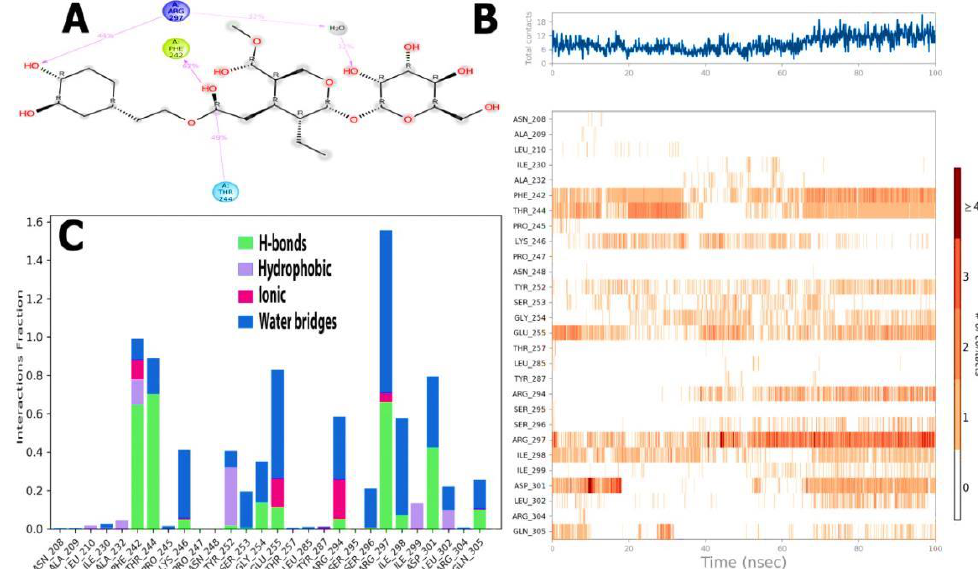
Figure 13. ( A ) Backbone RMSD values of the Cα atoms of the protein, ( B ) RMSF of the backbone atoms, ( C ) snapshots of the docking pose of oleuropein and the total H-bond intensity at various time intervals in the 20 ns complex MD simulations with EFLec .